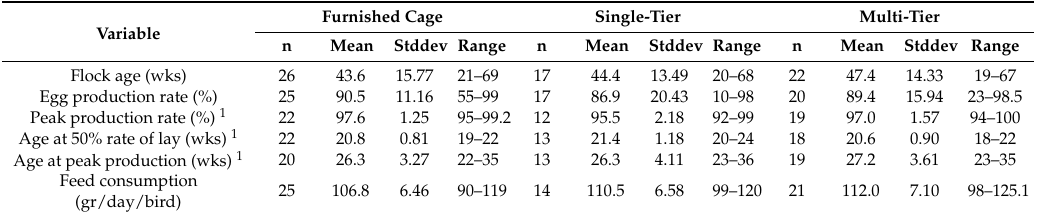
Table 9. Production parameters for 65 laying hen flocks placed between October 2016 and December 2017 according to housing system (furnished cage n = 26, single-tier n = 17, multi-tier n = 22) in Canada. Furnished Cage Single-Tier Multi-Tier Variable n Mean Stddev